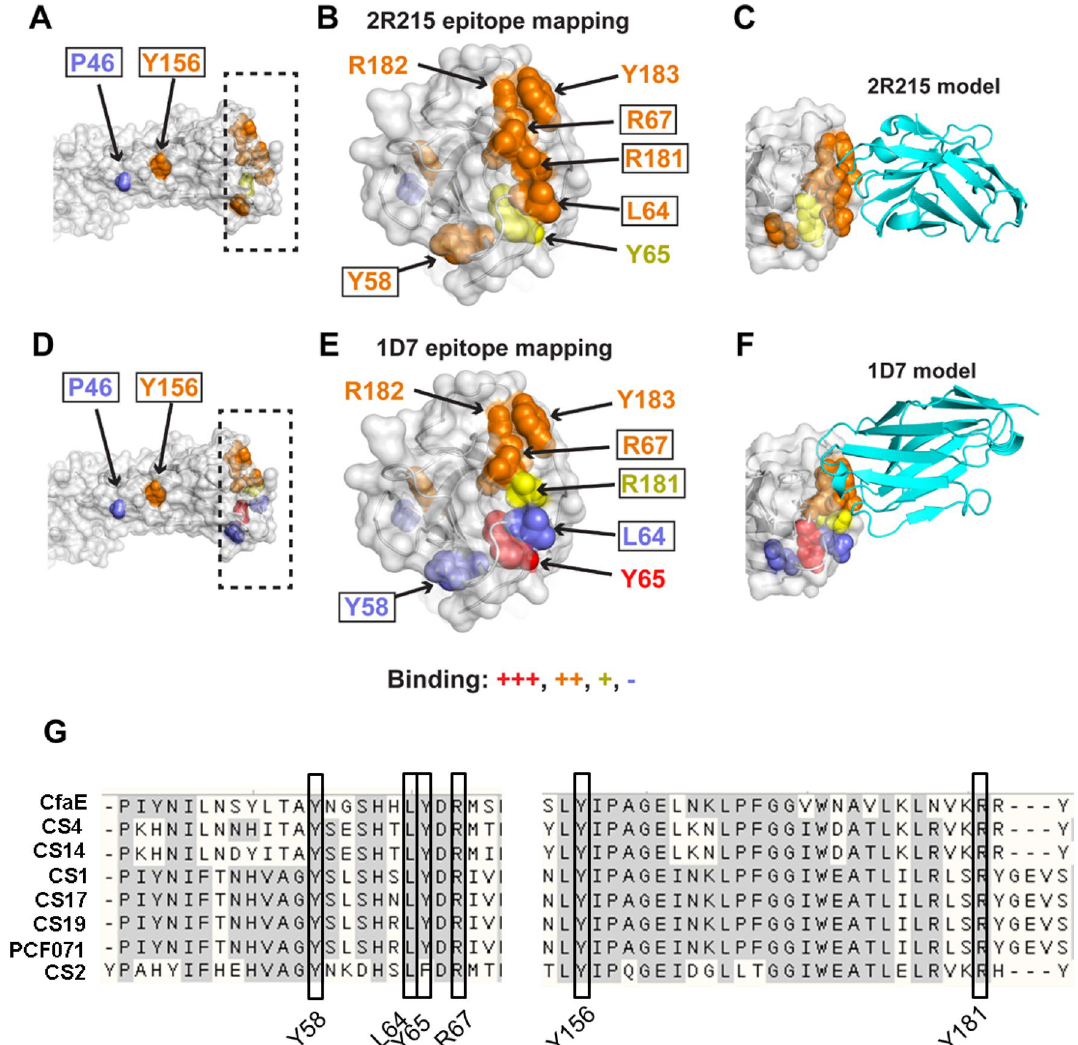
Figure 7. Epitope mapping of lead anti-ETEC VHHs. ( A – D ) Figures showing molecular structures were generated with PyMOL version 1.8 (Schrodinger, LLC, New York, NY, 2016, PyMOL | pymol.org). BioLuminate software [BioLuminate, Schrödinger Release 2016 ‐ 4, Schrödinger, LLC, New York, NY, BioLuminate ® | Schrödinger (schrodinger.com)] was used to perform initial modeling of nanobodies and docking simulations to CfaE. Binding effects of alanine substitutions are shown on the CfaE structure (PDB code 2HB0) for lead VHHs ( A ) 2R215 and (D) 1D7, with close-up of putative receptor binding region (boxed in A , D ) shown in ( B ) and ( E ). CfaE is shown as gray surface and cartoon, with residues tested by alanine scanning shown as spheres and colored by measured binding effects of CfaE alanine substitutions: major (+++, red), moderate (++, orange), minor (+, yellow), none (−, blue). Values correspond to those in Supplemental Table 2. To provide comparison of shared or distinct binding determinants, only residues with alanine scanning binding data for all nanobodies are shown. Residues are labeled in ( A ), ( B ), ( D ), ( E ), and residues that are fully conserved across 8 fimbrial adhesins are boxed. Docking models of (C) 2R215 and (F) 1D7 VHHs bound to CfaE were generated using ABodyBuilder 44 and ZDOCK 35 , with modeled bound VHHs shown as cyan cartoons. ( G ) Sequences of eight class 5 fimbrial adhesins were aligned using ClustalX algorithm. Inserts show regions in adhesion proteins where highly conserved residues (black box) required for nanobody binding are